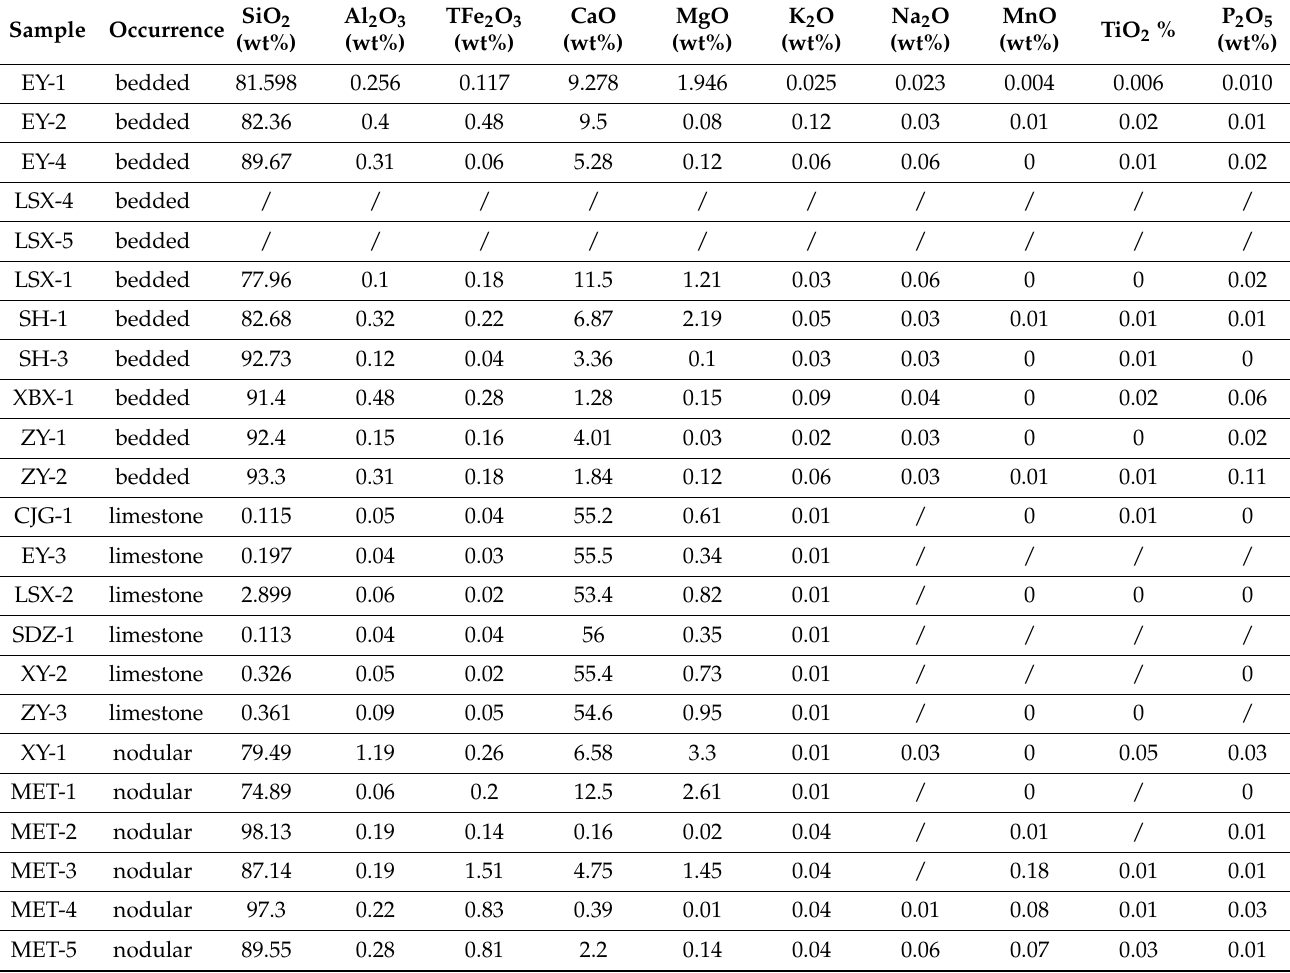
Table 1. Major elements of the Maokou cherts and limestones in the Sichuan